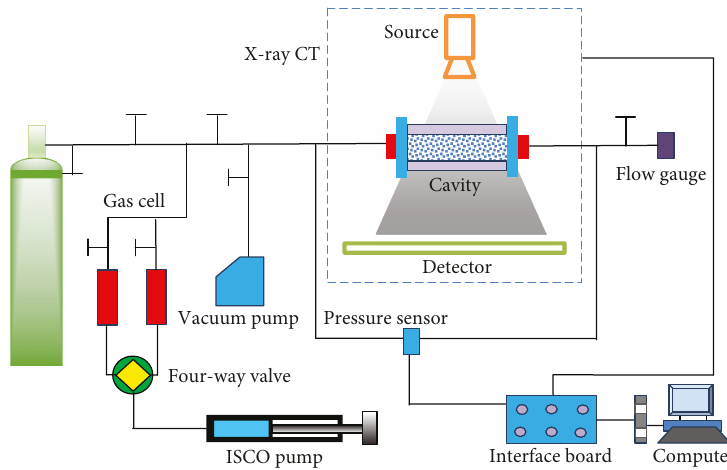
Figure 2: Schematic diagram of the experimental apparatus.